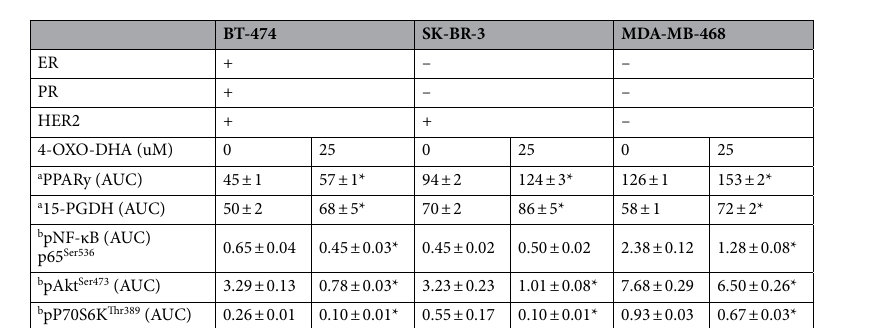
Table 2. The effect of 4-OXO-DHA on molecular targets in breast cancer cell lines. a Normalized to GAPDH. b Normalized to total amount of that protein detected by Western Blotting. c arbitarary units of chemiluminesence, AUC. Vaules with *, significantly different, p < 0.05.